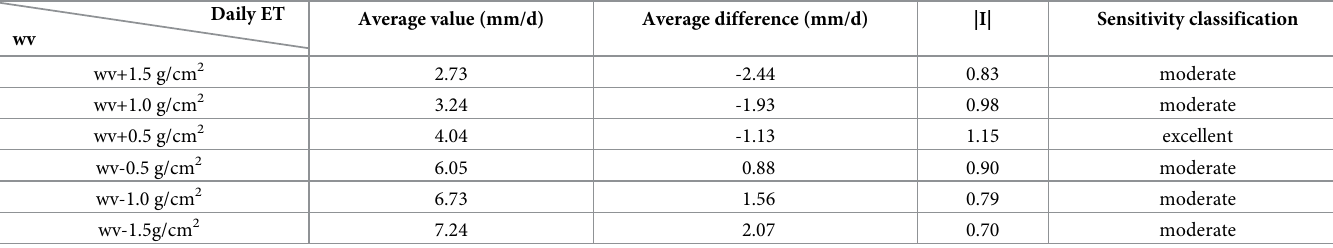
ET, evapotranspiration; wv, atmospheric water vapor.